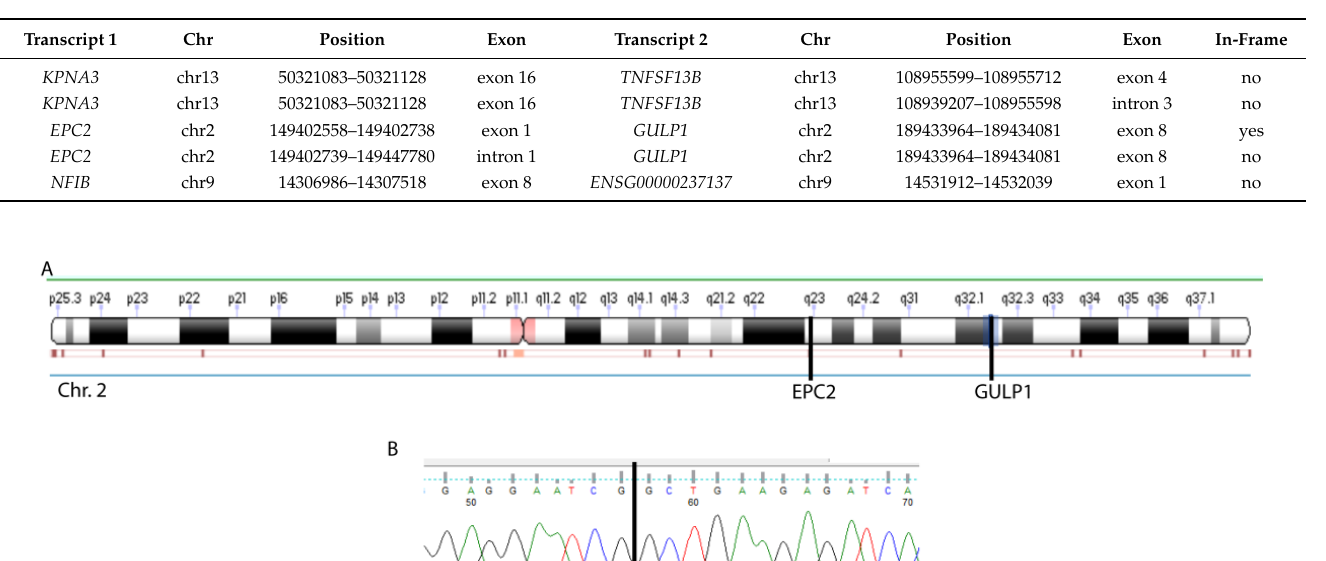
Table 1. Fusions detected in Medullobalstoma sample no. 80.